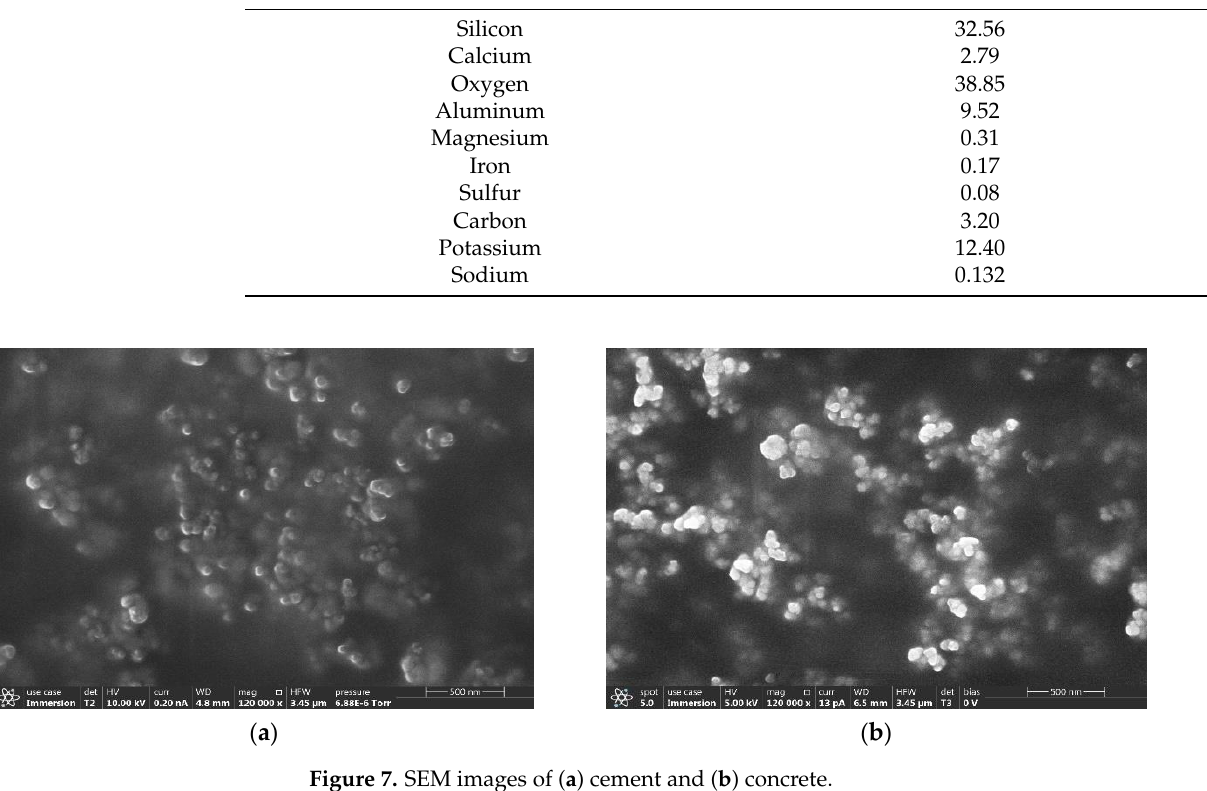
Figure 7. SEM images of ( a ) cement and ( b ) concrete.